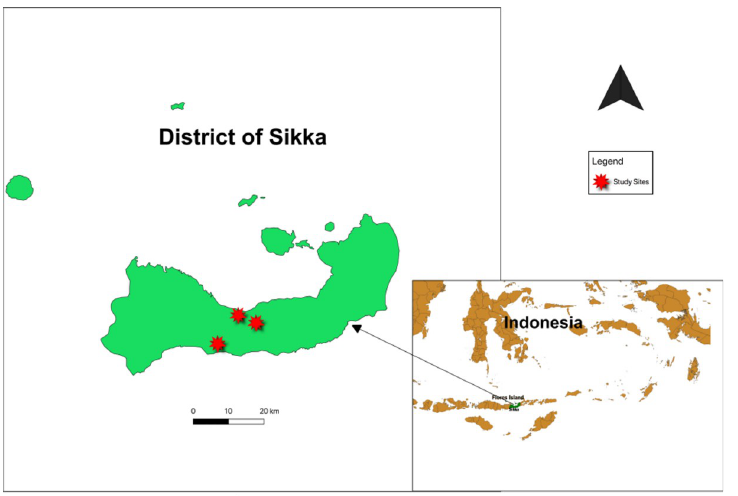
Fig 1. Study area. Base layer: https://www.statsilk.com/maps/download–free–shapefile–maps.